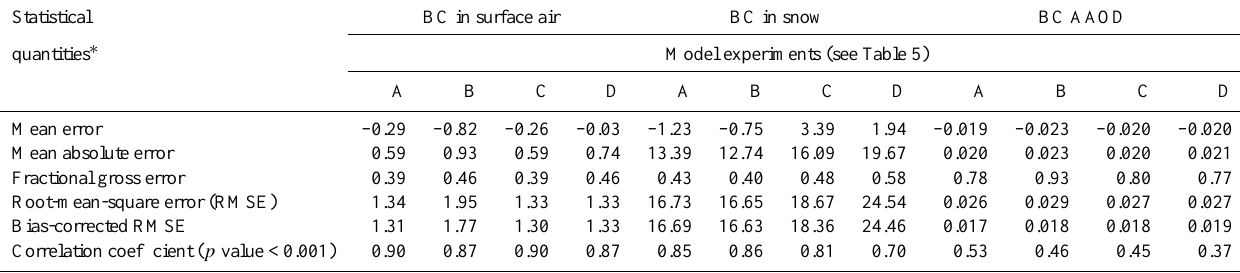
Table 6. Error statistics of GEOS-Chem simulations of BC in the Tibetan Plateau for 2006. Statistical BC in surface air BC in snow quantities